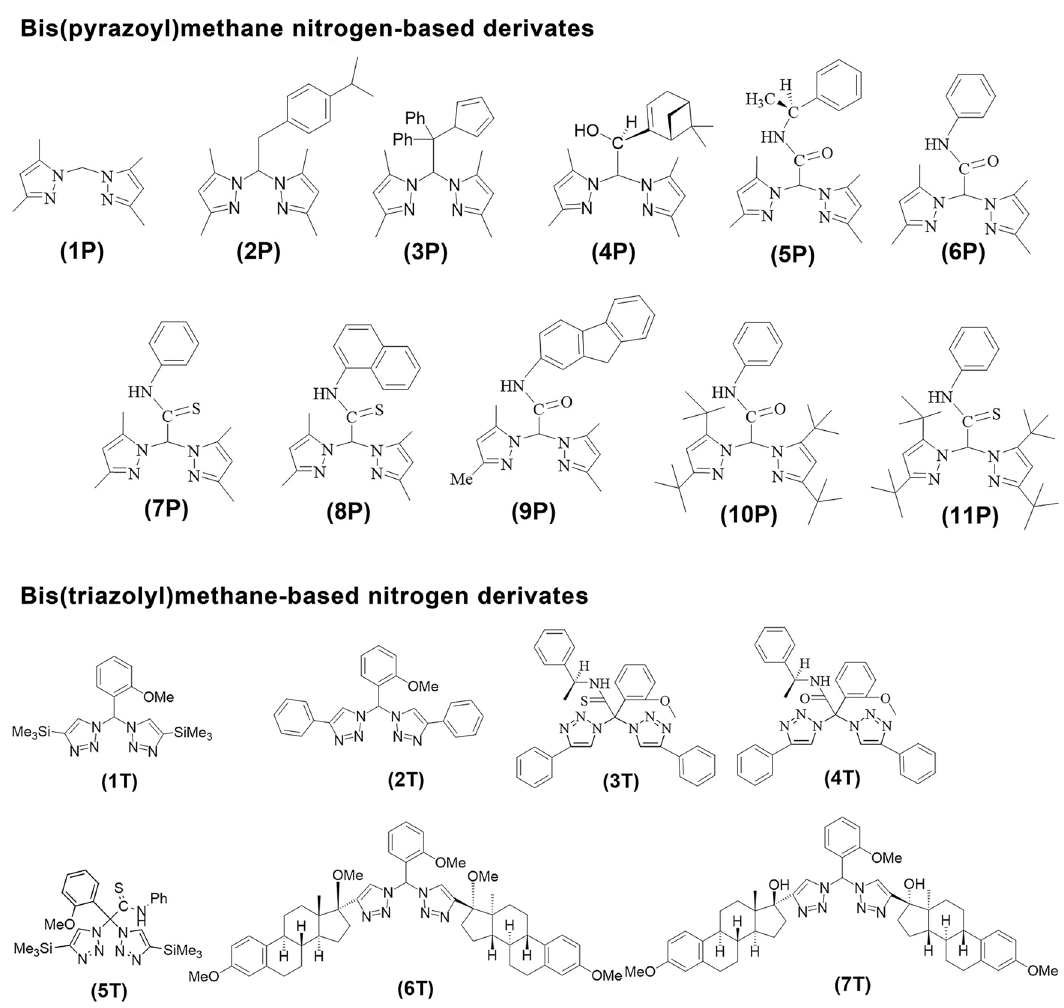
Figure 1. Chemical structures of both series of